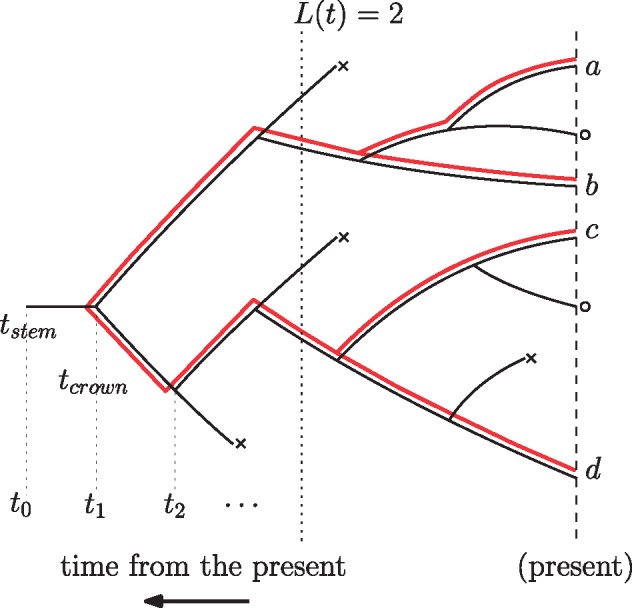
A phylogenetic tree \documentclass[12pt]{minimal}
\usepackage{amsmath}
\usepackage{wasysym}
\usepackage{amsfonts}
\usepackage{amssymb}
\usepackage{amsbsy}
\usepackage{upgreek}
\usepackage{mathrsfs}
\setlength{\oddsidemargin}{-69pt}
\begin{document}
}{}${\mathcal T}$\end{document} that evolves under a birth–death process with rates \documentclass[12pt]{minimal}
\usepackage{amsmath}
\usepackage{wasysym}
\usepackage{amsfonts}
\usepackage{amssymb}
\usepackage{amsbsy}
\usepackage{upgreek}
\usepackage{mathrsfs}
\setlength{\oddsidemargin}{-69pt}
\begin{document}
}{}$\lambda, \mu$\end{document} and with sampling at the present with probability \documentclass[12pt]{minimal}
\usepackage{amsmath}
\usepackage{wasysym}
\usepackage{amsfonts}
\usepackage{amssymb}
\usepackage{amsbsy}
\usepackage{upgreek}
\usepackage{mathrsfs}
\setlength{\oddsidemargin}{-69pt}
\begin{document}
}{}$\rho$\end{document}. Lineages ending in a death (extinction) are marked by \documentclass[12pt]{minimal}
\usepackage{amsmath}
\usepackage{wasysym}
\usepackage{amsfonts}
\usepackage{amssymb}
\usepackage{amsbsy}
\usepackage{upgreek}
\usepackage{mathrsfs}
\setlength{\oddsidemargin}{-69pt}
\begin{document}
}{}$\times$\end{document} whereas lineages at the present that are not sampled are marked by o. The reconstructed tree on the sampled extant individuals is indicated by the additinal lines starting at \documentclass[12pt]{minimal}
\usepackage{amsmath}
\usepackage{wasysym}
\usepackage{amsfonts}
\usepackage{amssymb}
\usepackage{amsbsy}
\usepackage{upgreek}
\usepackage{mathrsfs}
\setlength{\oddsidemargin}{-69pt}
\begin{document}
}{}$t_1$\end{document}.